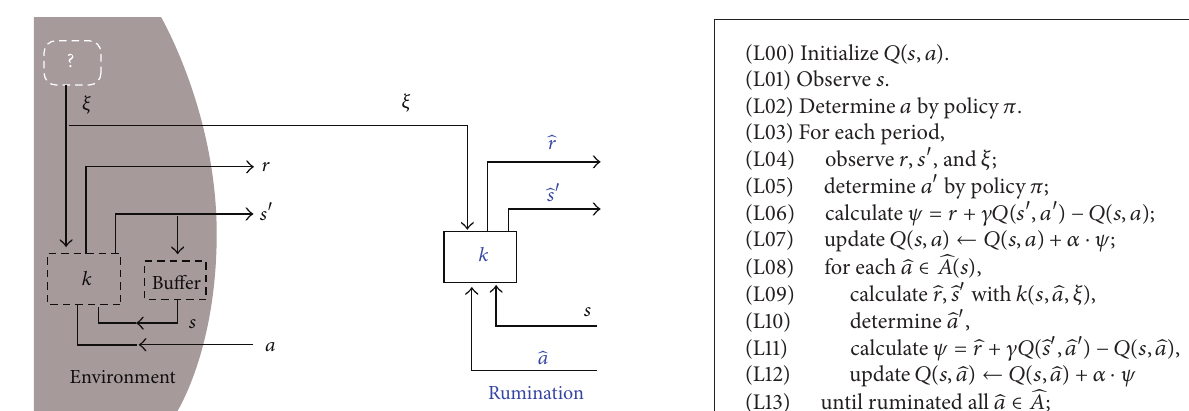
Figure 2: Environment, knowledge of its structure, and rumination.